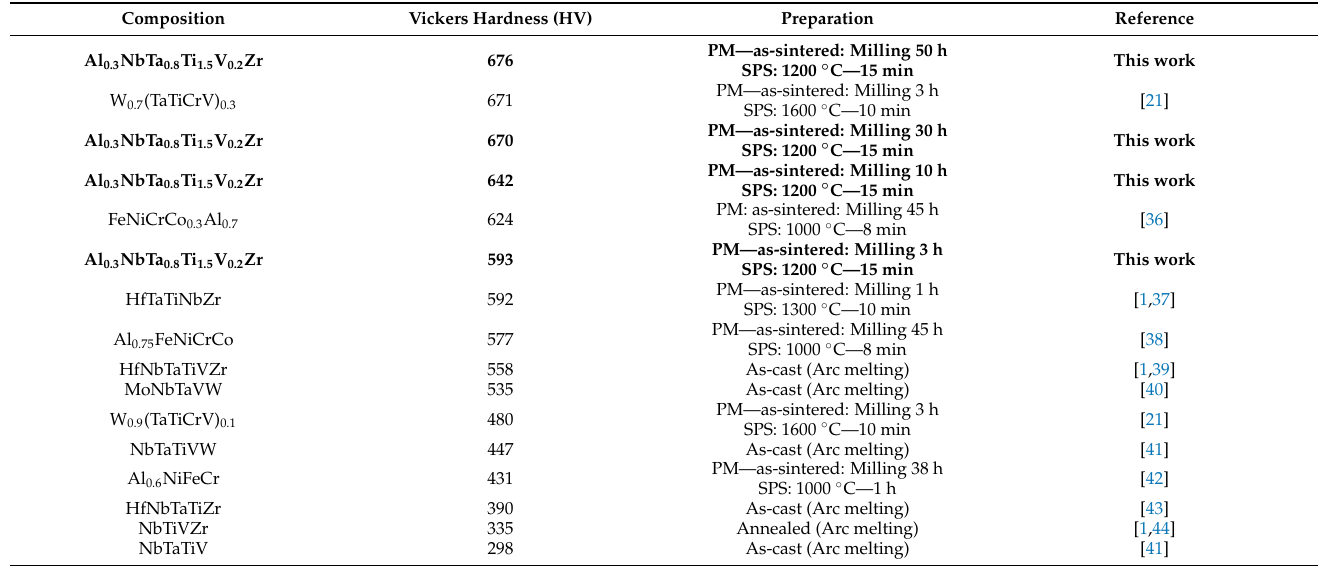
Table 6. Hardness values of several HEAs found in the literature including the method of preparation, in comparison to the alloys produced in this work. The total milling times were discriminated, as well as the SPS conditions of maximum temperature of sintering and dwell time at this temperature for the referenced